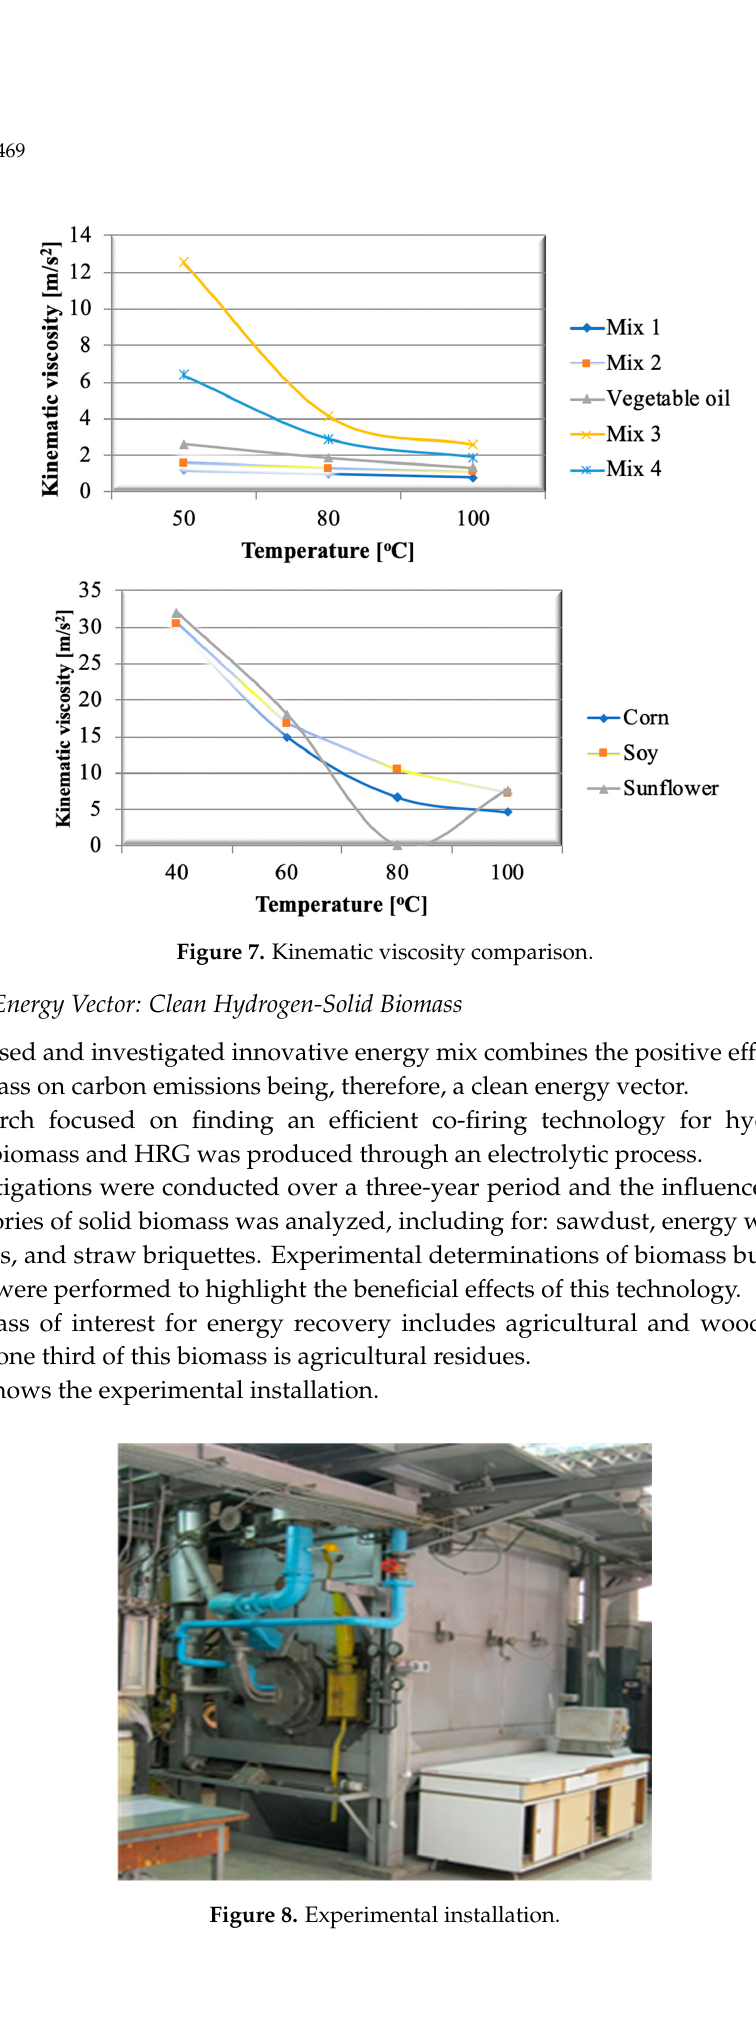
Figure 8. Experimental